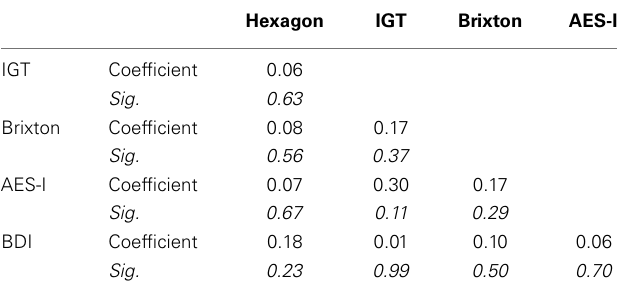
Table 3 | Correlations between global apathy and tests scores .